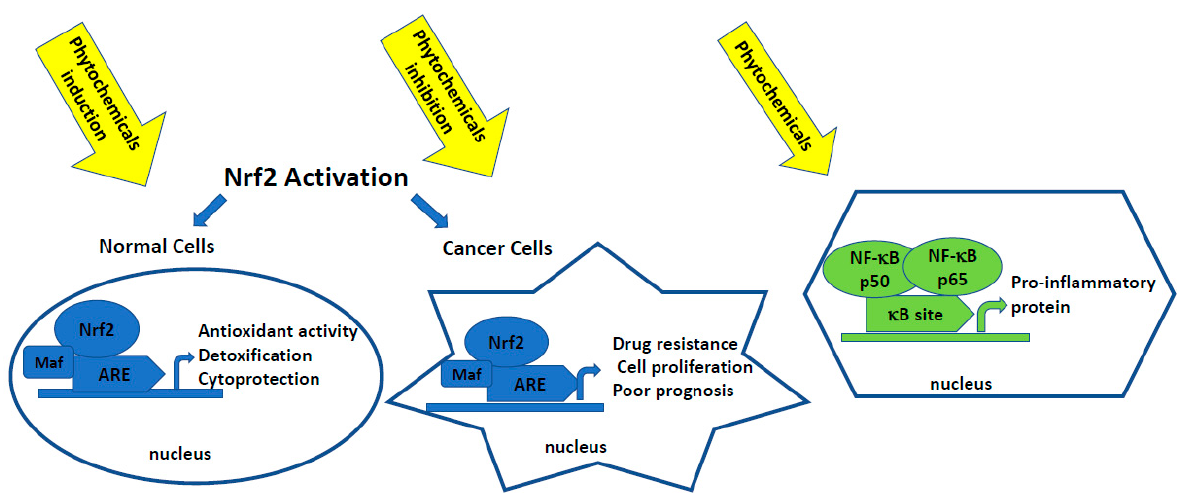
Figure 2. Shematic presentation of the activation of Nrf2 and NF- κ B pathways. Phytochemicals as single compounds or their combinations affecting these pathways may act in the early stages of carcinogenesis as chemopreventive agents or support convention therapy protecting against chemoresistance.